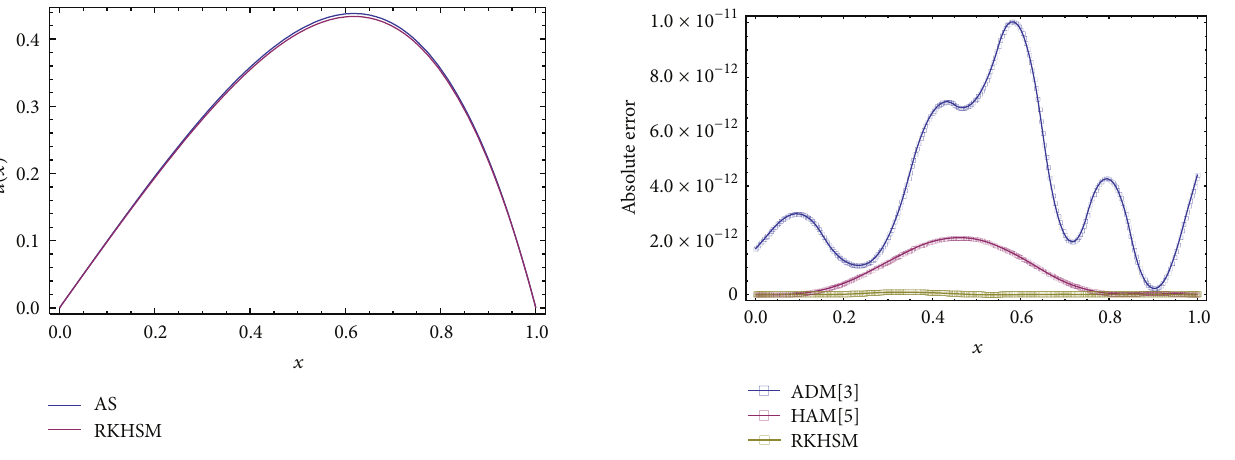
Figure 3: Comparison of analytical solution and RKHSM solution for Example 11.